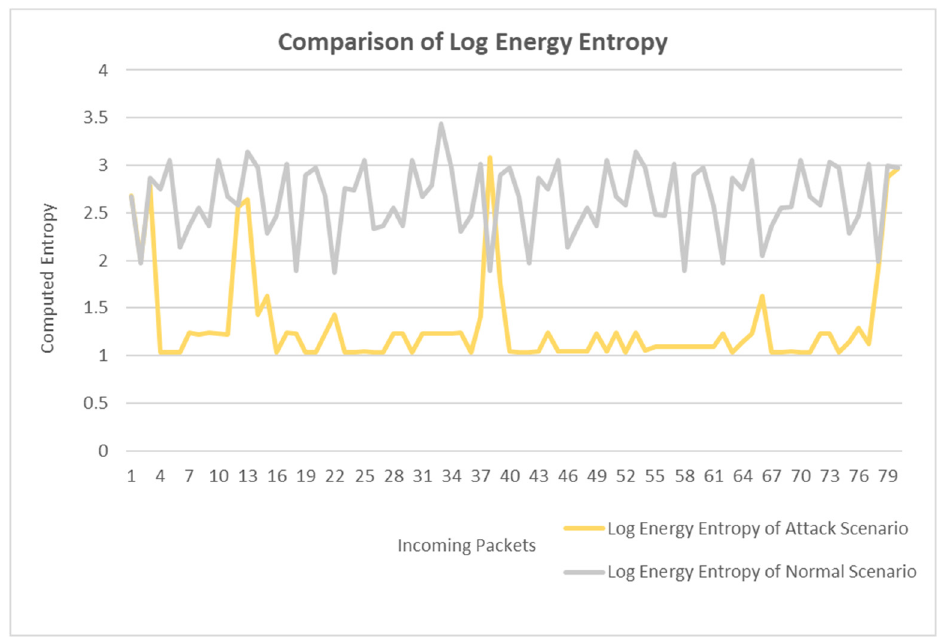
Figure 5. Log energy entropy variation.